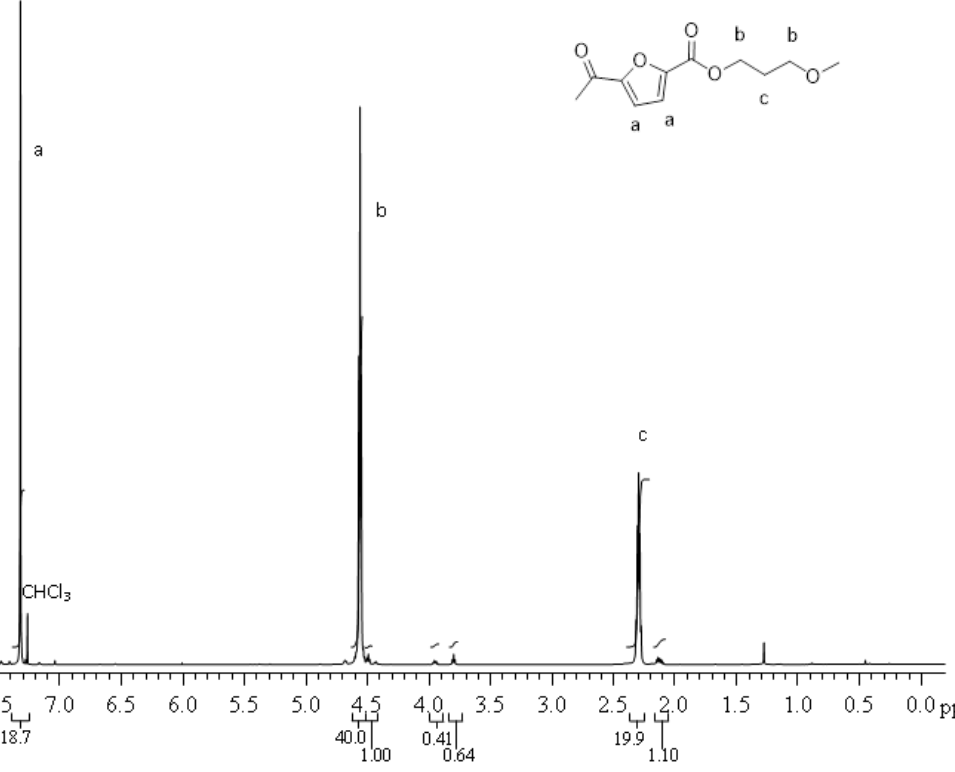
Figure 2. 1 H NMR spectrum of PPF.